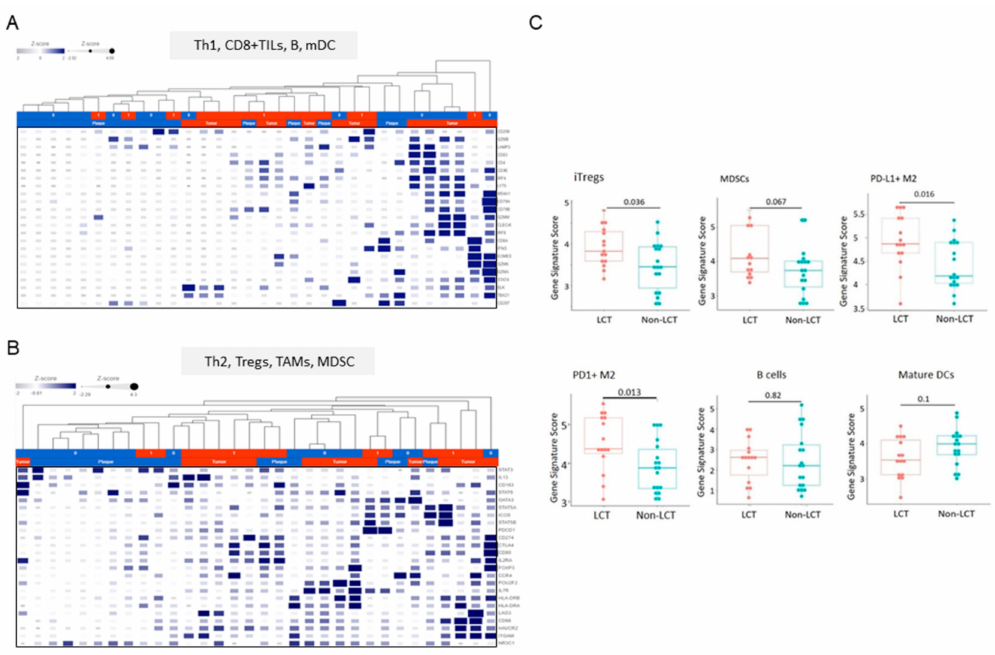
Figure 5. Immune cell gene signatures in the microenvironment of LCT-MF vs. non-LCT. Heatmap visualization of RNA-Seq data: Th1, CD8+ TILs, and B cells ( A ) Th2, Tregs, TAMs, MDSCs and DCs signature ( B ) in the microenvironment of MF-LCT vs. non-LCT. ( C ) RNA-Seq analysis with genes scored by − log2 (RPKM) to evaluate the genetic expression of iTregs, MDSCs, PD-L1+ M2, PD1+ M2, B cells, and mature DCs in MF-LCT vs. non-LCT. “limma” was used with p -value < 0.05 and fold change > 1.5 as the cutoff values.